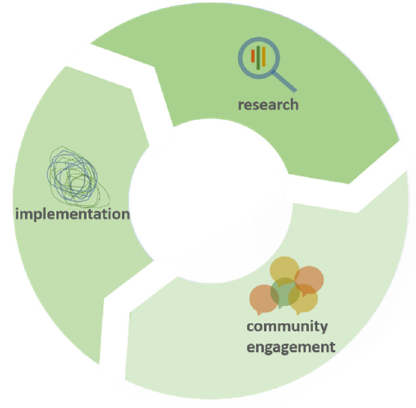
Figure 2. Scheme of the proposed CDM (image by the authors).